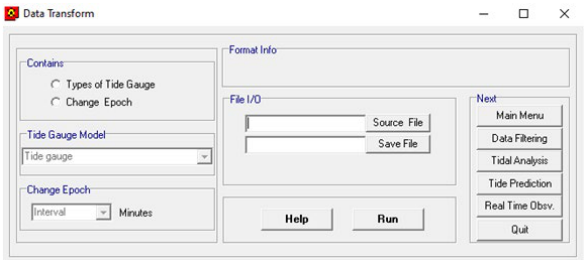
Figure 3. Visualisation of Data Transform Menu (TOTIS)